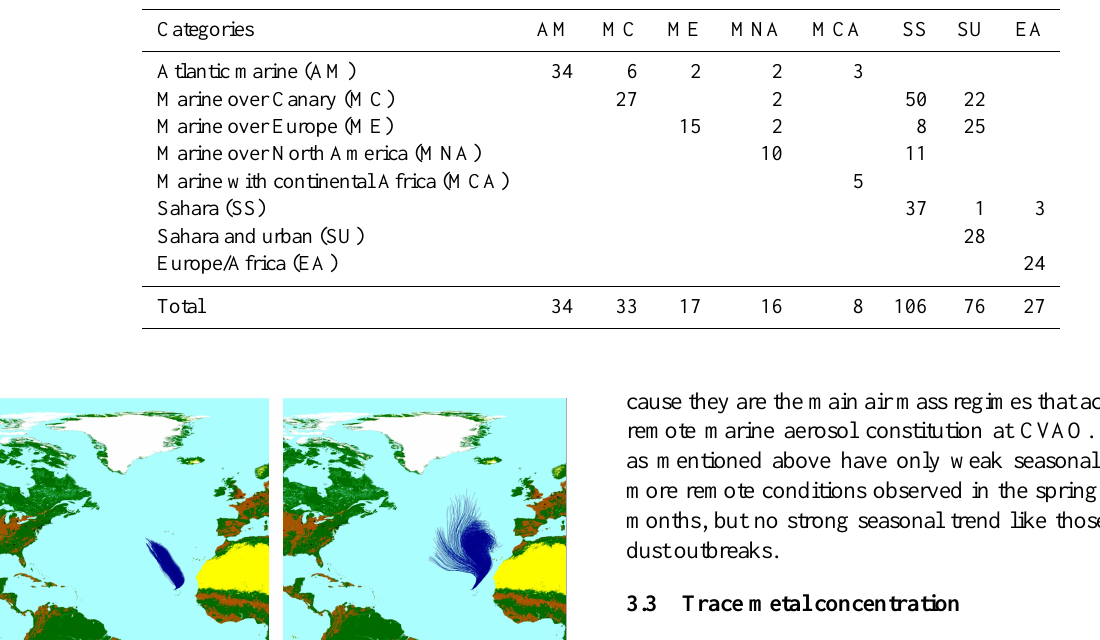
Table 2. Air mass back trajectory classification of all 317 samples with the various categories representing the likely air mass origin in the last 96 h prior to arrival at CVAO. Table also shows a mixed scenario, in which air mass had crossed both categories before arriving at CVAO.